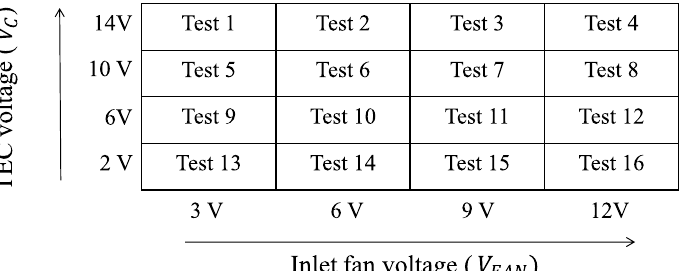
Figure 7. Test grid of the exhaustive